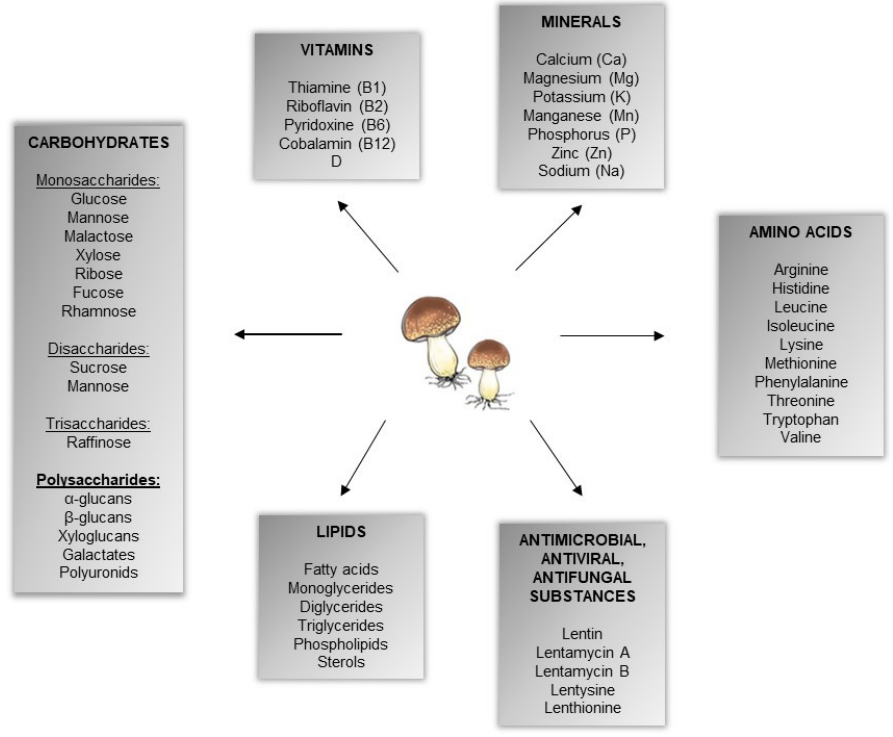
Figure 1. Main active compounds of Lentinula edodes .